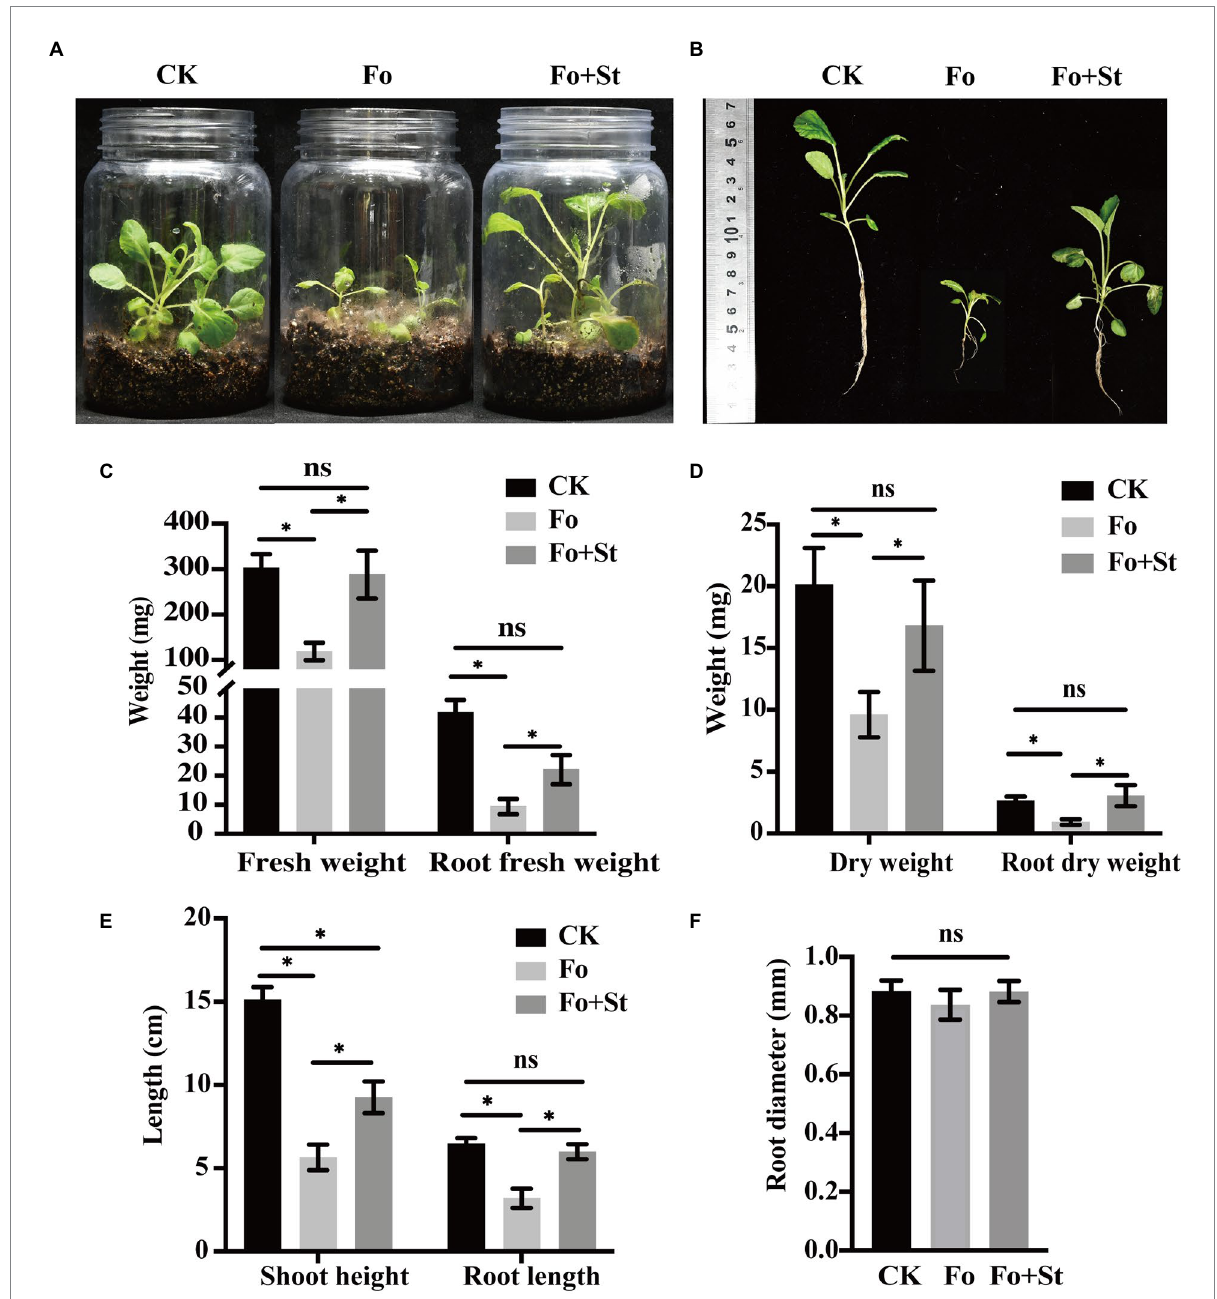
FIGURE 2 Control effect of St-220 on root rot disease of Salvia miltiorrhiza seedlings. (A) Symptoms of root rot developed on seedlings inoculated with Fusarium oxysporum (Fo) and mixture of F. oxysporum and St-220 (Fo + St) at 30 DAI, while no symptoms were observed on seedlings inoculated with sterile water (CK). (B) The entire plant of the seedlings in CK, Fo, and Fo + St treatment. Measurement of the fresh weight (C) , dry weight (D) , shoot height, root length (E) , and root diameter (F) of seedlings inoculated. Data are mean ± SE ( n = 10). Means were compared with ANOVA analysis in combination with Tukey post-test. Means were considered statistically different when p < 0.05, Bars with ∗ above are statistically different, ns above are not statistically